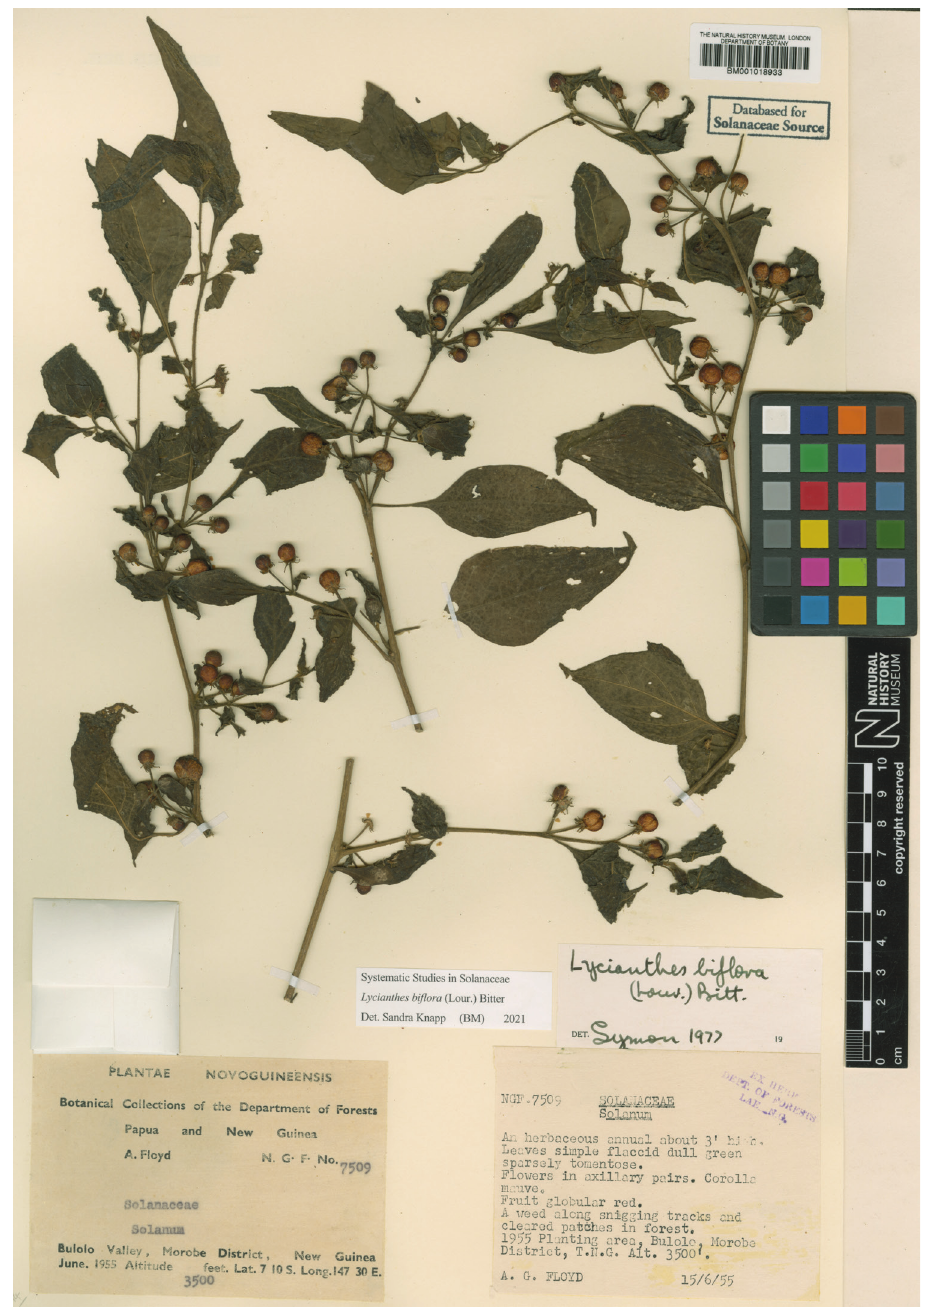
Figure 11. Lycianthes biflora herbarium specimen. Papua New Guinea. Morobe: Floyd NGF-7509 (BM001018933). Courtesy of the Trustees of the Natural History Museum, London, reproduced with